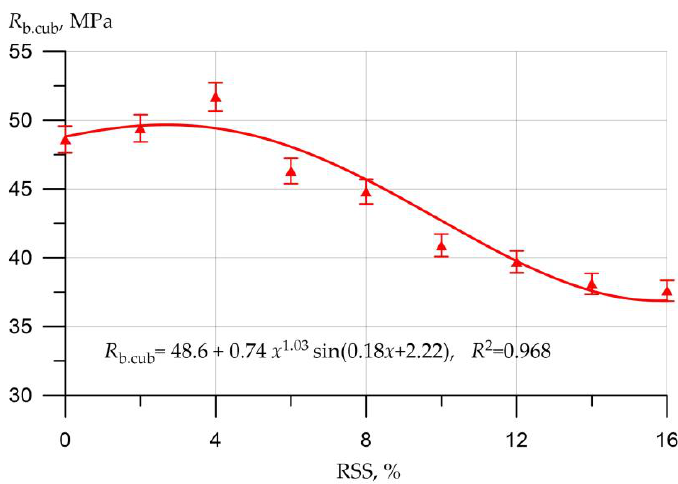
Figure 4. The influence of local replacement of CA with RT seed shells on CS . b cub R .